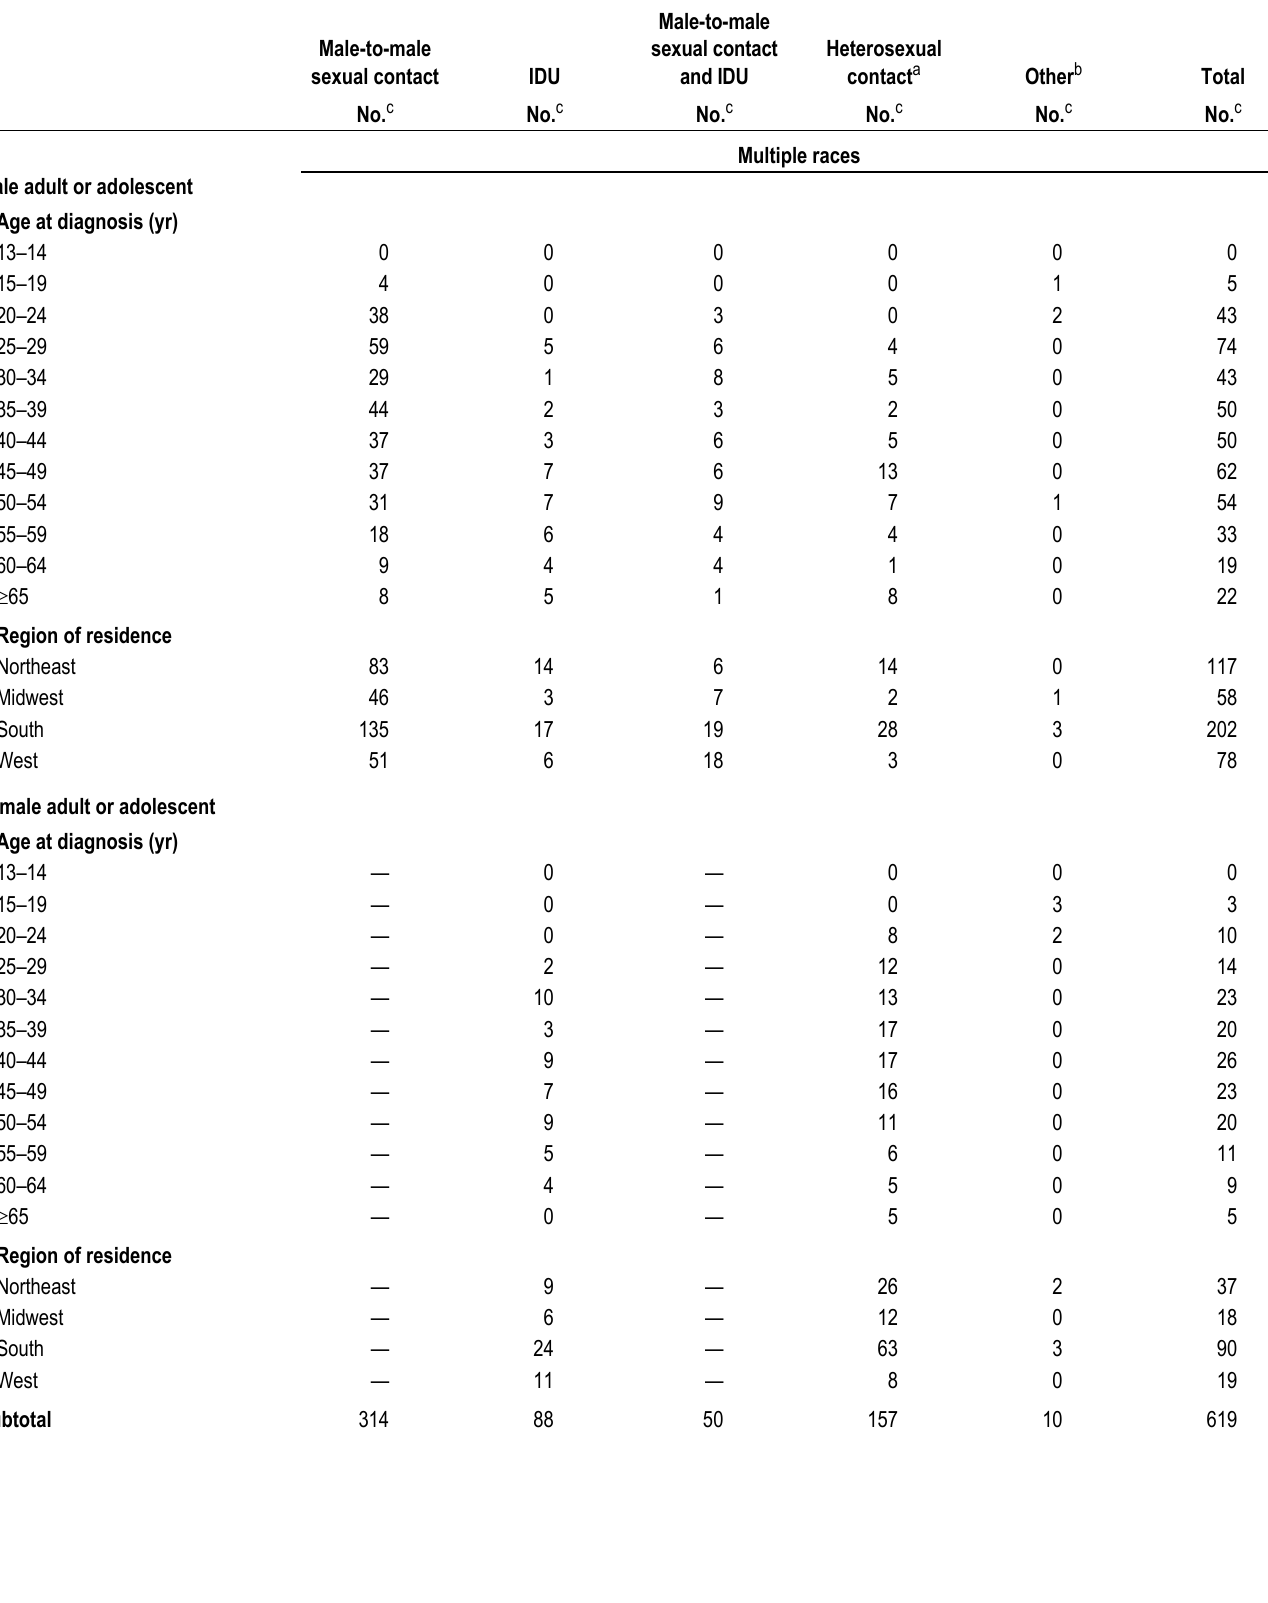
Table 6a. Stage 3 (AIDS), by transmission category, race/ethnicity, and selected characteristics, 2015—United States